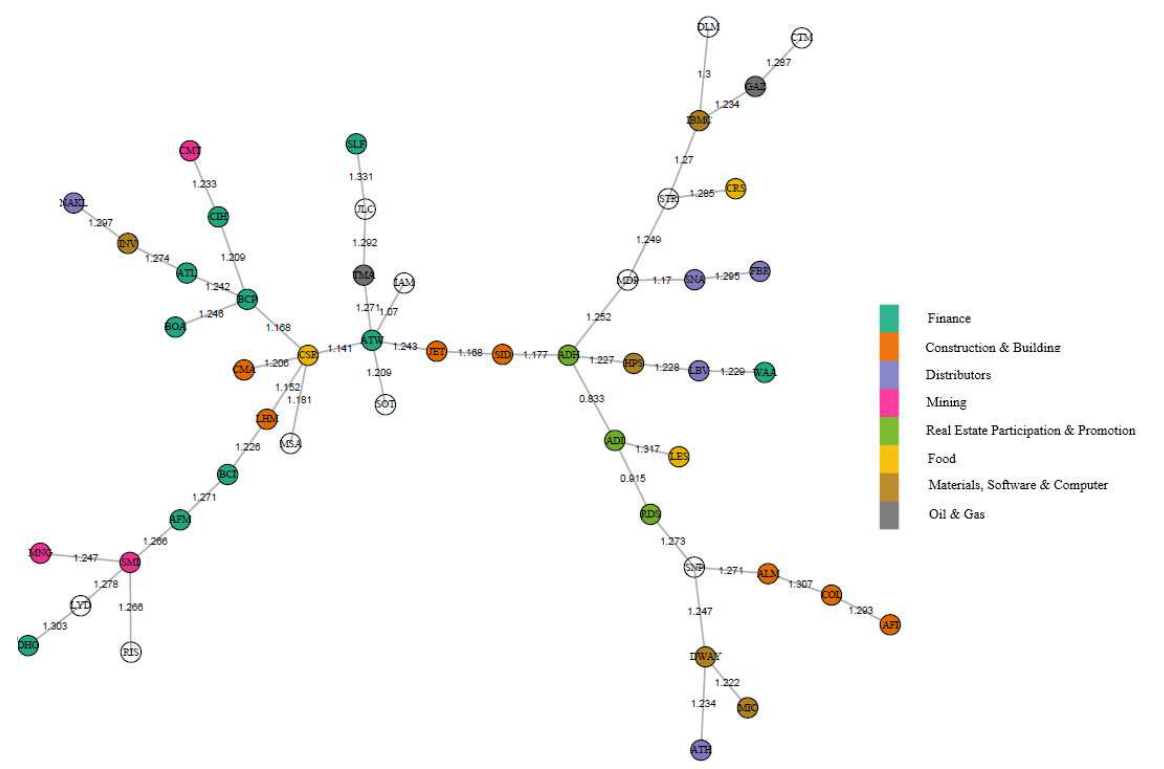
Figure 3. After crisis minimum spanning tree of the MSE network (March 1, 2021 to February 18,